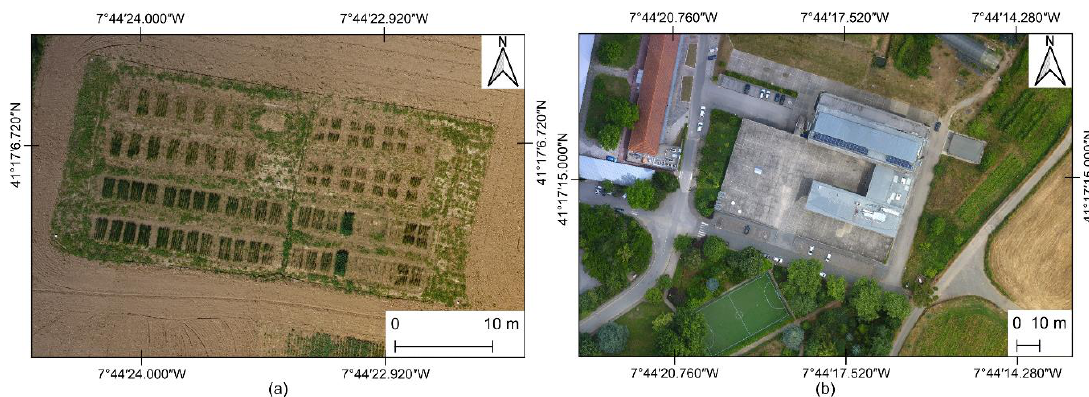
Figure 8. Orthophoto mosaics produced in MicMac in first study area ( a ), and second study area ( b ).